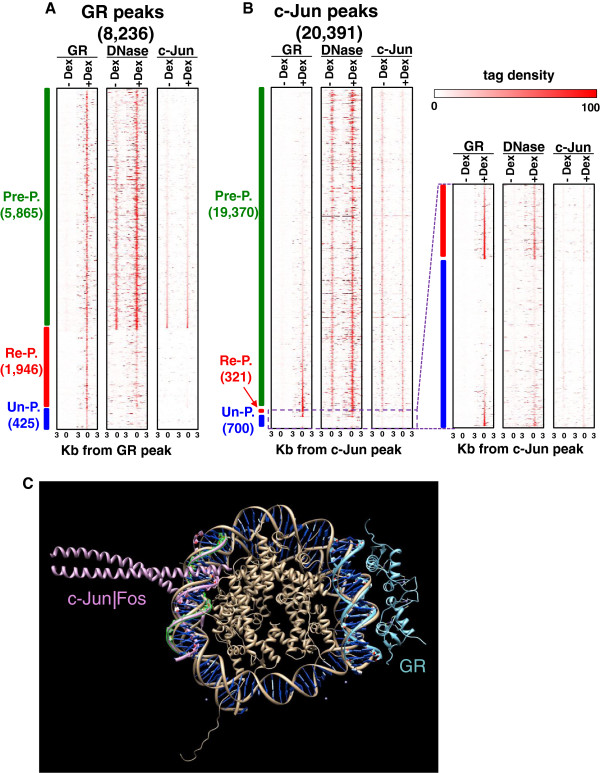
Chromatin accessibility of GR and AP-1 motifs in 3134 cell line in vivo. (A-B) Density of sequenced tags for GR, c-Jun ChIP-seq and DNase I-seq were counted in 3-Kb up and downstream of the center of (A) the GR ChIP-seq peaks and (B) the c-Jun ChIP-seq peaks. GR peaks are placed in three groups, pre-programmed DHS peaks, re-programmed DHS peaks, and GR peaks that are not in a DHS peak termed as un-programmed. The bin size is 300-bps and slide window is 150-bps. Sequence reads for GR, DHS, and c-Jun are normalized w.r.t the total tag-density. Re-programmed and un-programmed c-Jun peaks are enlarged to better present the tag-density pattern. (C) Overlapping crystal structures for the nucleosome (PDB ID: 1AOI), GR (1R4O) and c-Jun|Fos (1FOS) showing GR can bind the nucleosome-occluded DNA while c-Jun|Fos has steric hindrances.